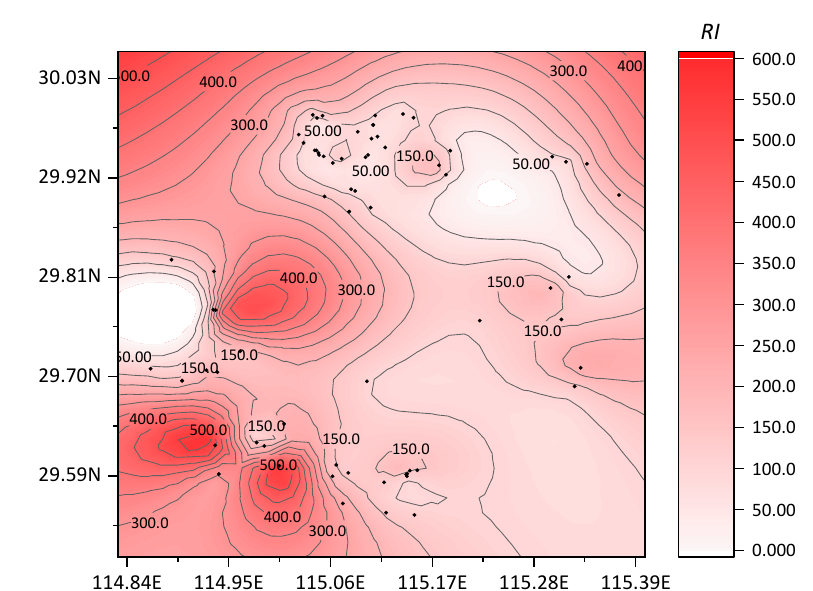
Figure 6. Distribution map of the integrated potential ecological risk index ( RI ).